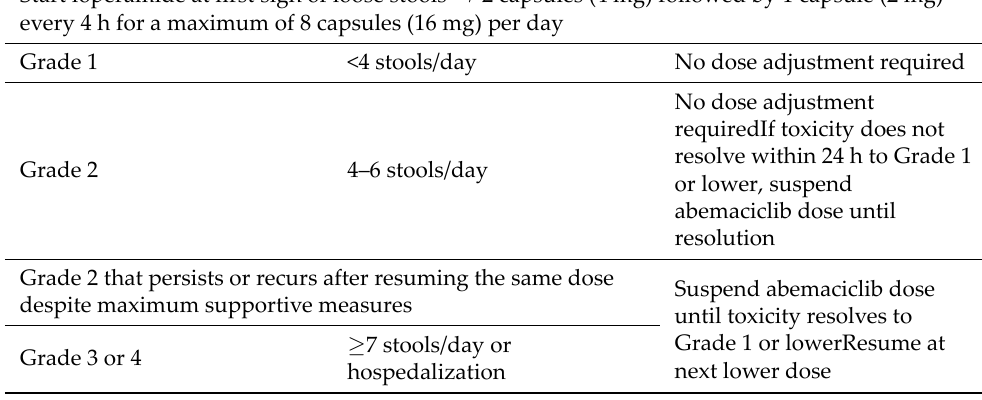
Table 3. Synoptic table on the guideline‑based management of abemaciclib‑induced diarrhea. Table adapted from summary of product characteristics of abemaciclib of European Medicines Agency (EMA)